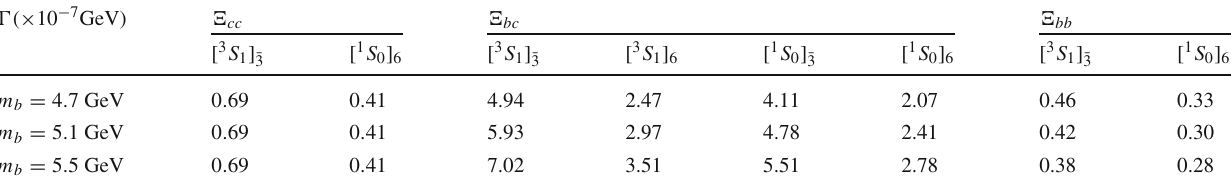
Table 6 The theoretical uncertainties for the production of baryons (cid:2) QQ (cid:3) via Higgs boson decays by varying m b = 5 . 1 ± 0 . 4 GeV (cid:6)( × 10 − 7 GeV)